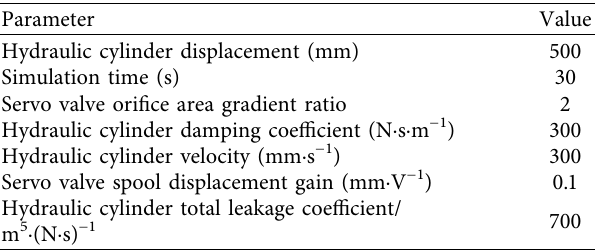
Table 1: Simulation